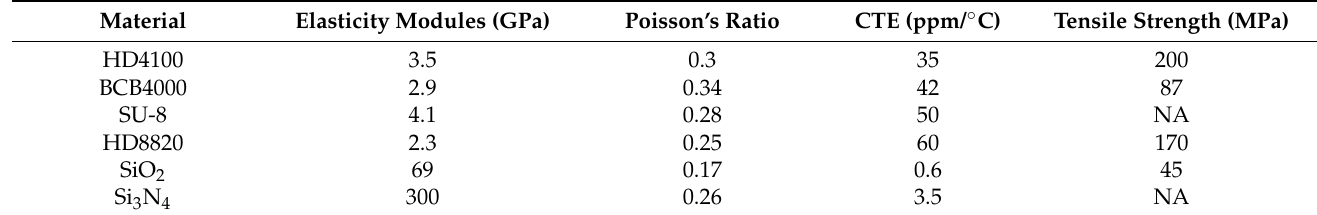
Table 2. Material properties of 3D interconnection structure.